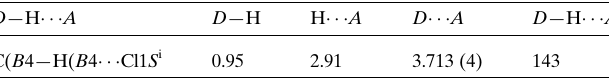
Table 1 Hydrogen-bond geometry (A˚ , (cid:3) ).